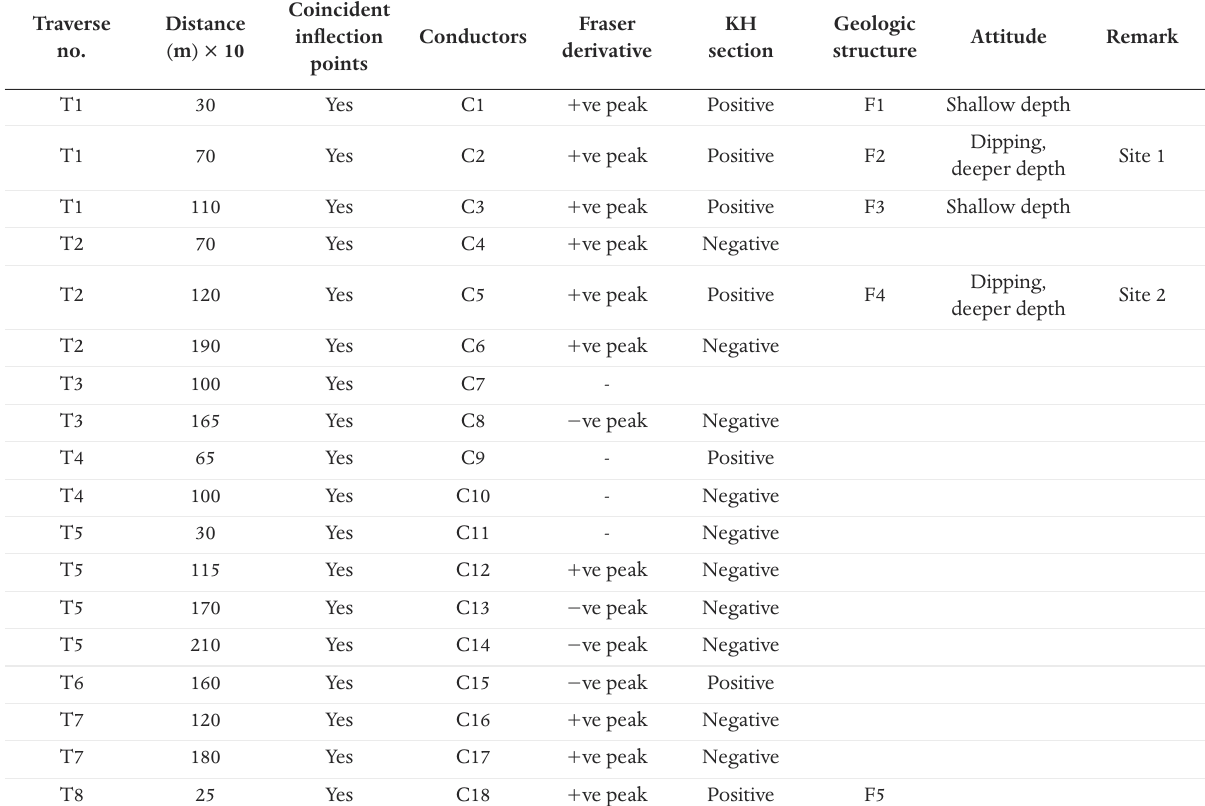
Table 1. VLF-EM interpreted